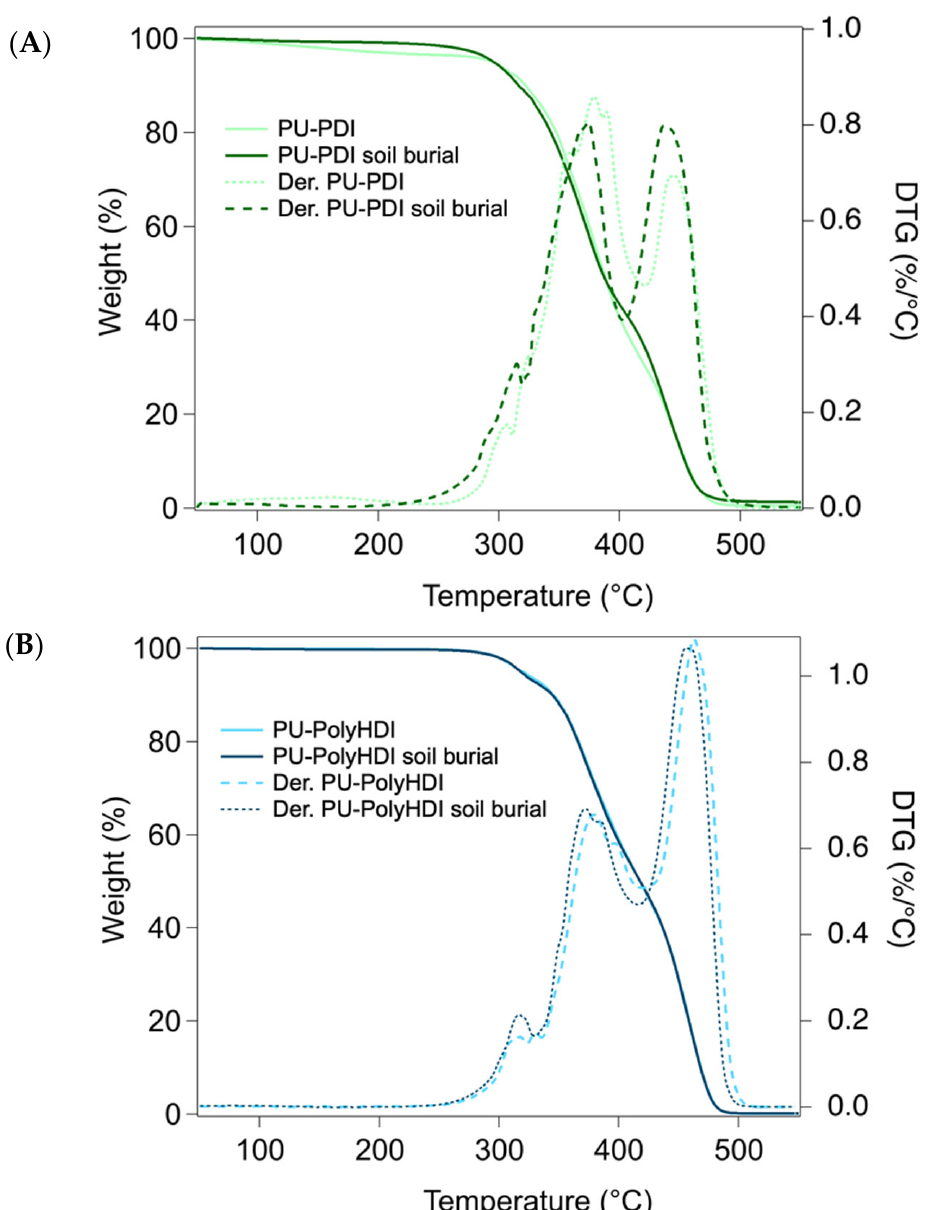
Figure 7. TGA and DTG of PUs samples before and after the soil burial test. ( A ) PU ‐ PDI and ( B ) PU ‐ PolyHDI.